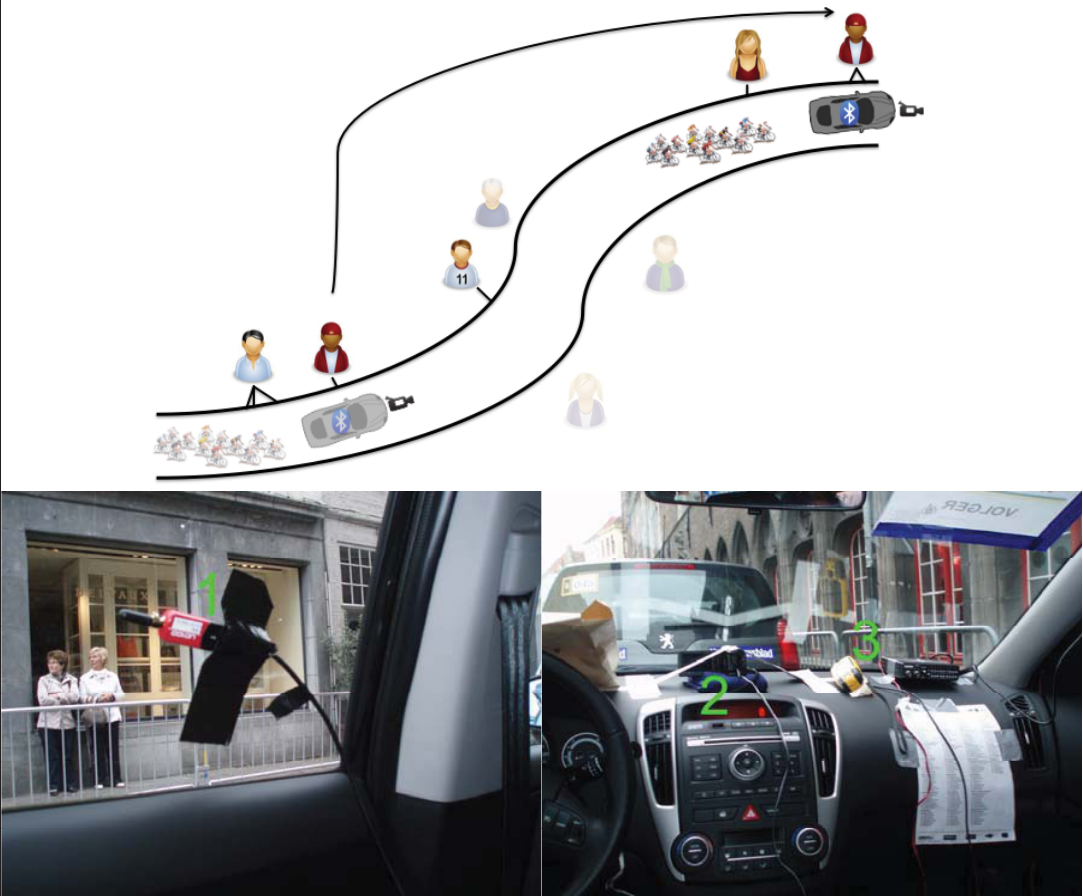
Figure 1. Mobile sensor deployment during the race. Top: schematic overview of the methodology, bottom: actual deployment (1: Bluetooth sensor, 2: video camera, 3: GPS unit).